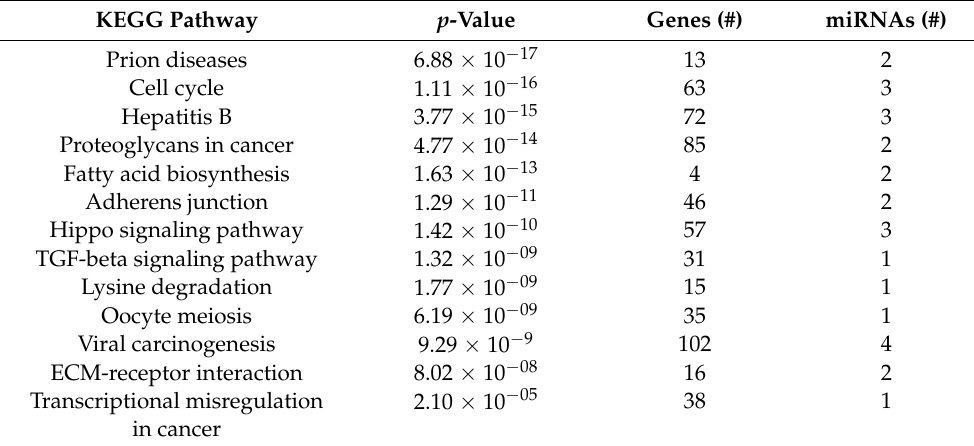
Table 3. Physiologic pathways targeted by the five candidate